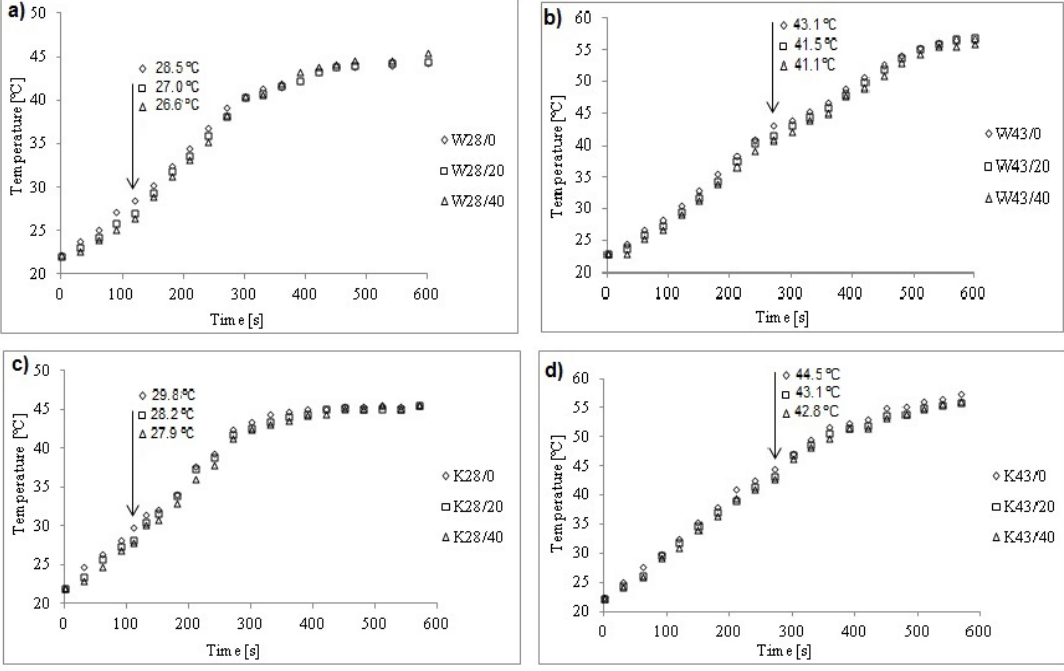
Figure 5. The temperature dependence on heating time for: ( a ) woven fabrics W28 / 0, W28 / 20, W28 / 40; ( b ) wovenfabrics W43 / 0, W43 / 20, W43 / 40; ( c ) knitted fabrics K28 / 0, K28 / 20, K28 / 40; ( d ) knitted fabrics K43 / 0, K43 / 20, K43 / 40.